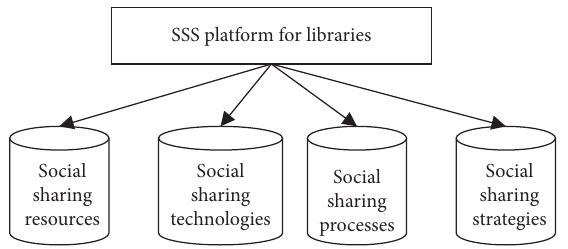
Figure 1: Framework of the SSS system for